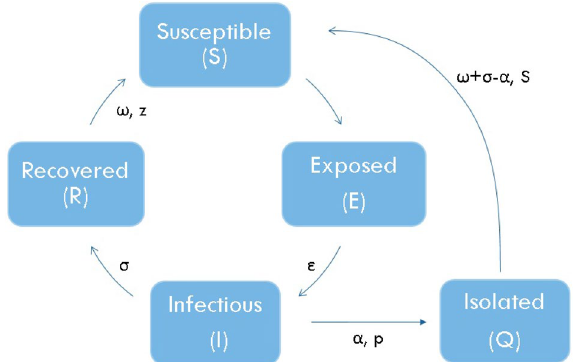
Figure 1. Compartment scheme of a SEIQR model. ǫ , α , σ and ω are the latency, isolation, infectiousness and immunity periods, p is the portion of infected people which is isolated and z is the survival